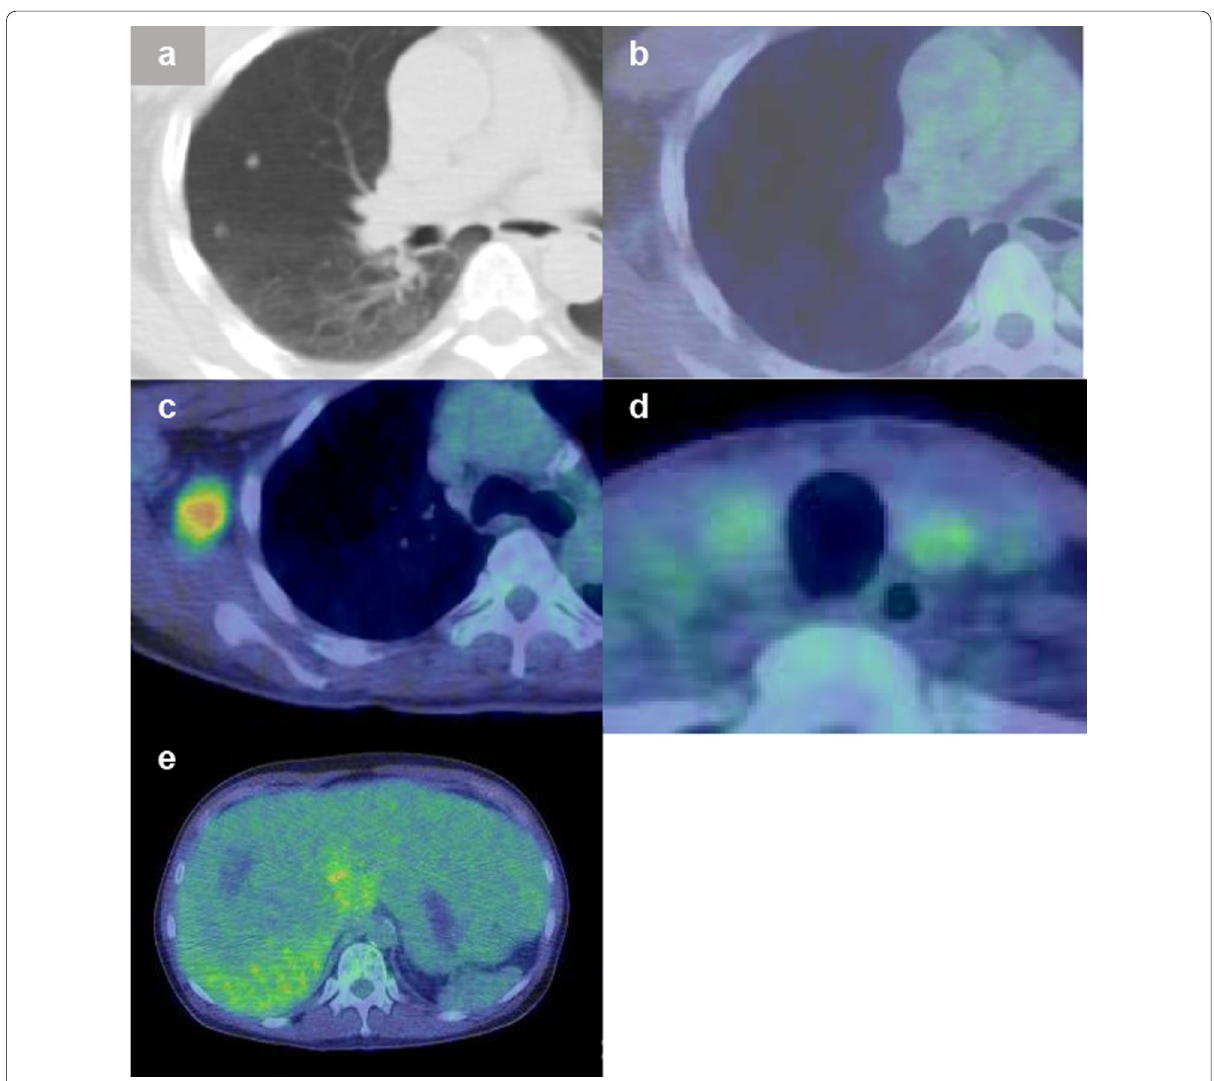
Fig. 1 Fluorodeoxyglucose–positron emission tomography/computed tomography findings. a , b No specific uptake in multiple pulmonary nodules. c Right axillary tumor showed an accumulation with a standardized uptake value maximum of 5.1. d Both thyroid lobes showed only faint accumulation. e Decreased FDG accumulation consistent with a hepatic tumor was